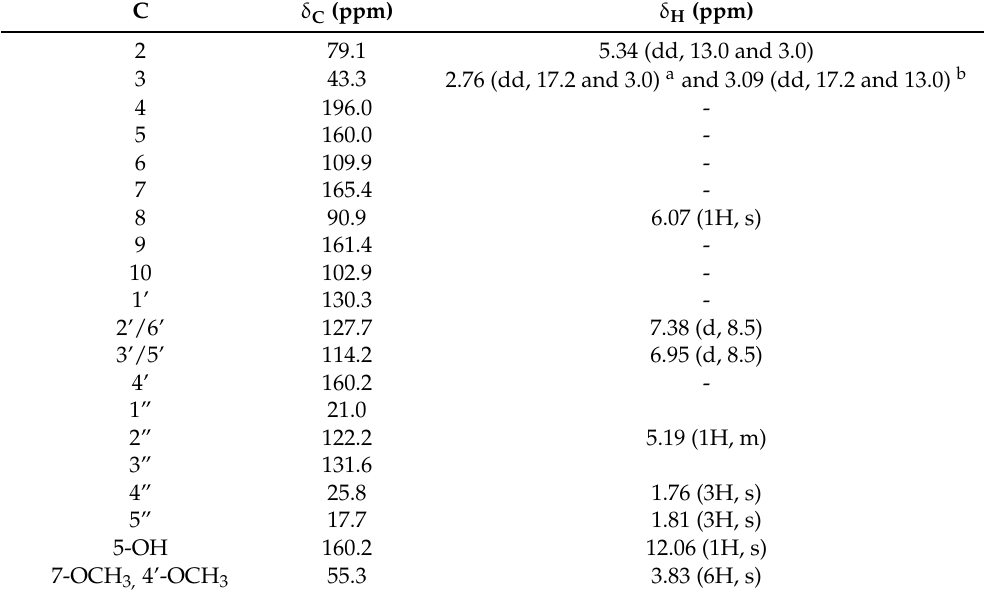
Table 1. 1 H-NMR and 13 C-NMR spectroscopic data of compound 6 (CDCl 3 , 400 MHz, J in Hz).